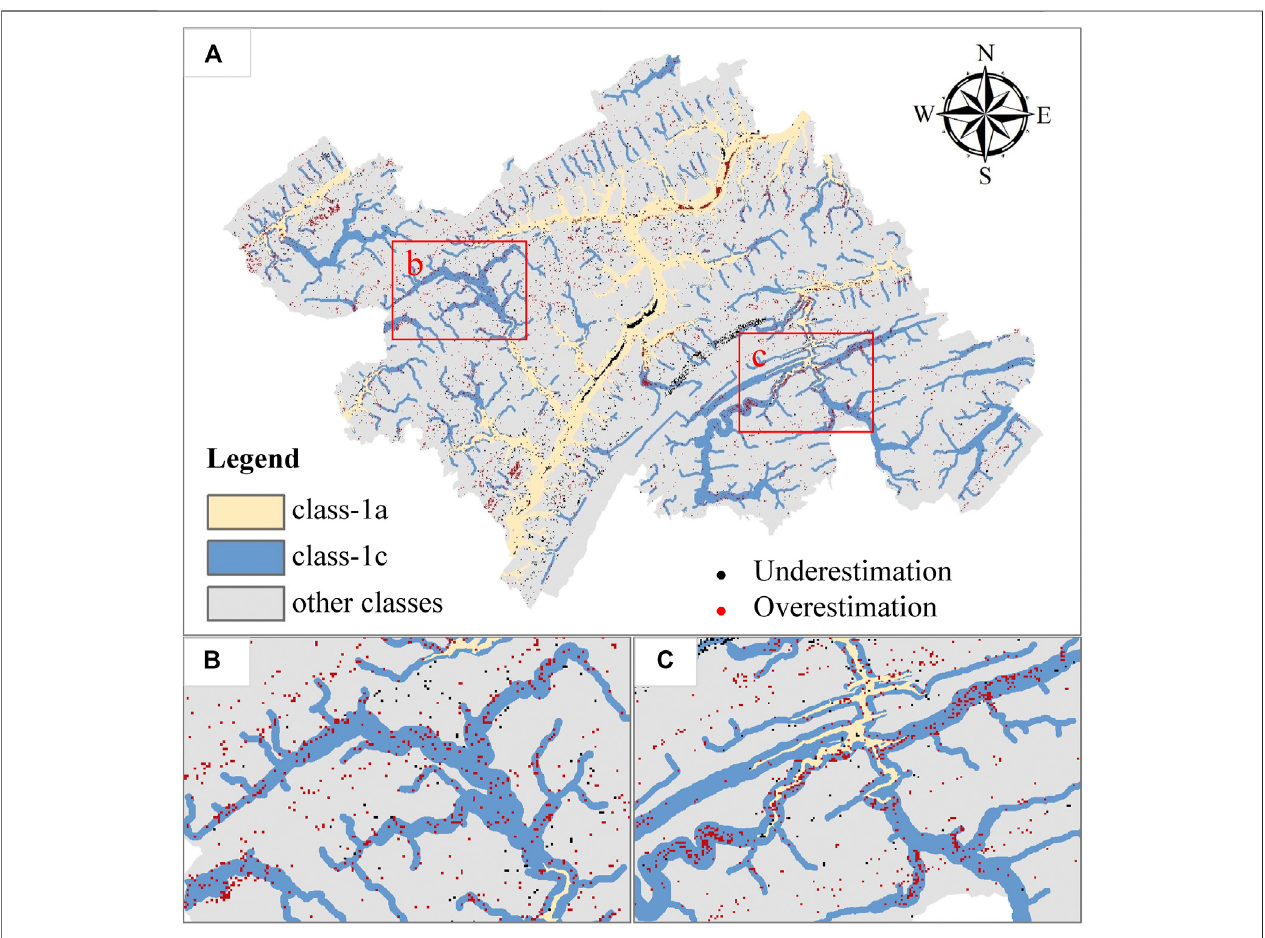
FIGURE 10 | Spatial location of underestimations and overestimations in relation to rivers-class-1. (A) Whole study area; (B) typical region; (C) typical region.